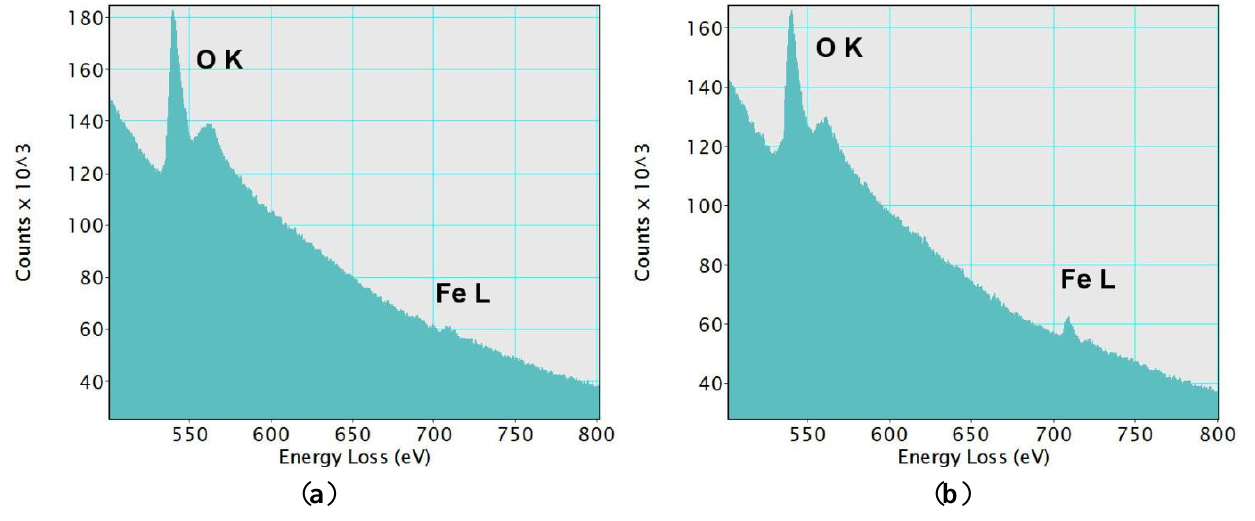
Figure 3. Electron Energy Loss Spectroscopy (EELS) spectra from ( a ) region 1 and ( b ) region 2 in Figure 2. A small L3 peak at the edge threshold can be noticed in the spectrum from region 1. In region 2, only traces of iron were detected. In both cases, the O peaks were clearly K